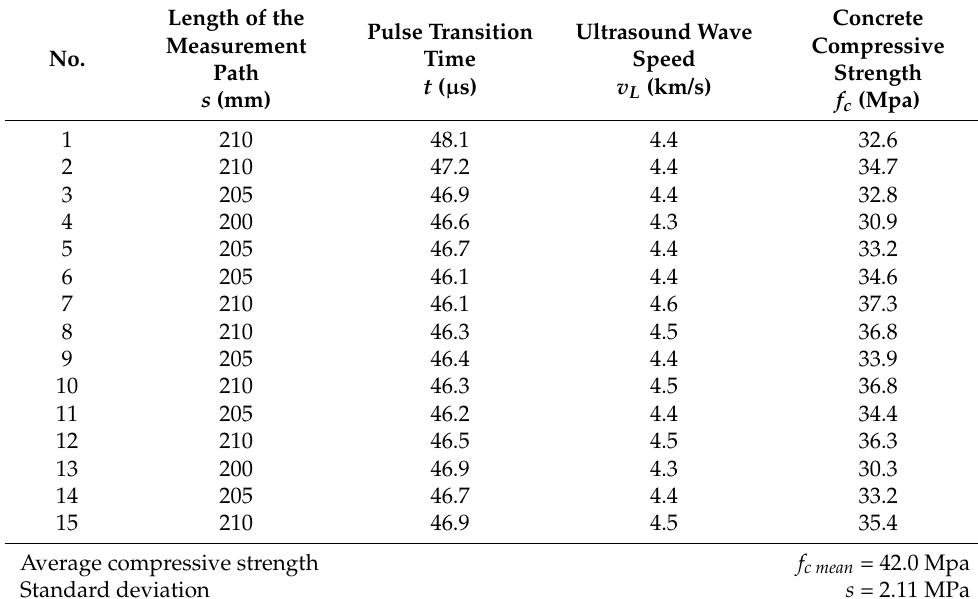
Table 4. Ultrasonic test results (girder G11, Hall